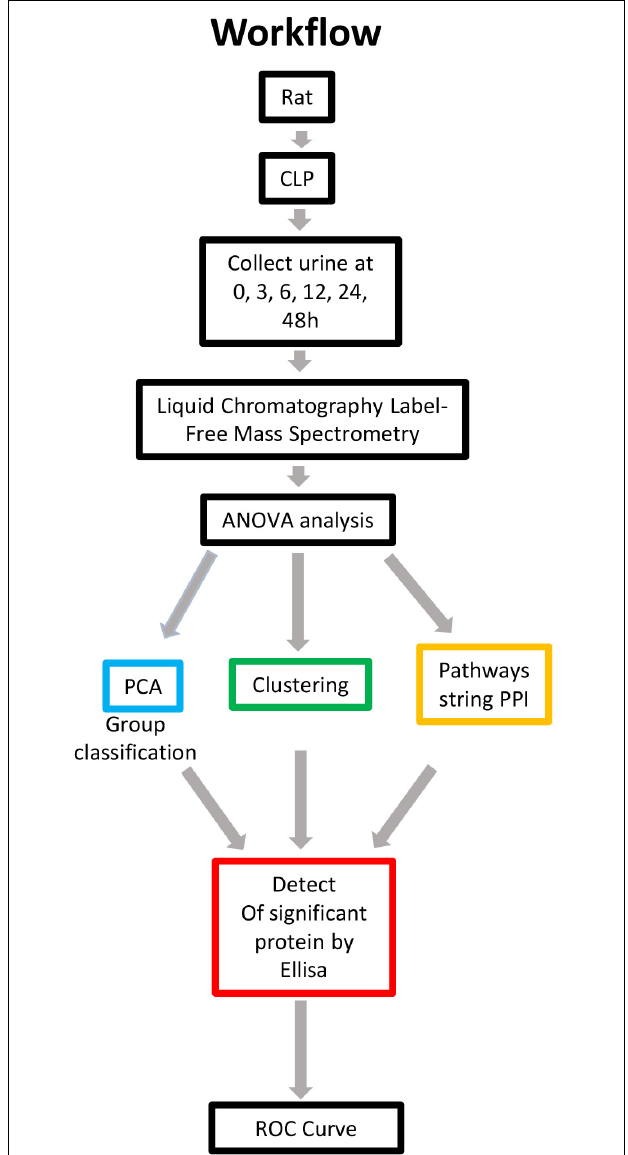
FIGURE 1 | Overview of methods employed and results obtained. Rat urine was collected at 0, 3, 6, 12, 24, and 48 h and subjected to label-free MS. One-way ANOVA was performed with a p value cutoff of 0.05. For group classification, PCA, hierarchical clustering analysis and PPI were used, and significant proteins were identified. Furthermore, validation was performed on selected proteins in human urine. AUC and a diagnostic cutoff value of differential expression protein were calculated by ROC curve. ANOVA, analysis of variance; MS, mass spectrometry; PCA, principal component analysis; PPI, protein-protein interaction (via OmicsNet and STRING). AUC, area under curve; ROC, receiver operating